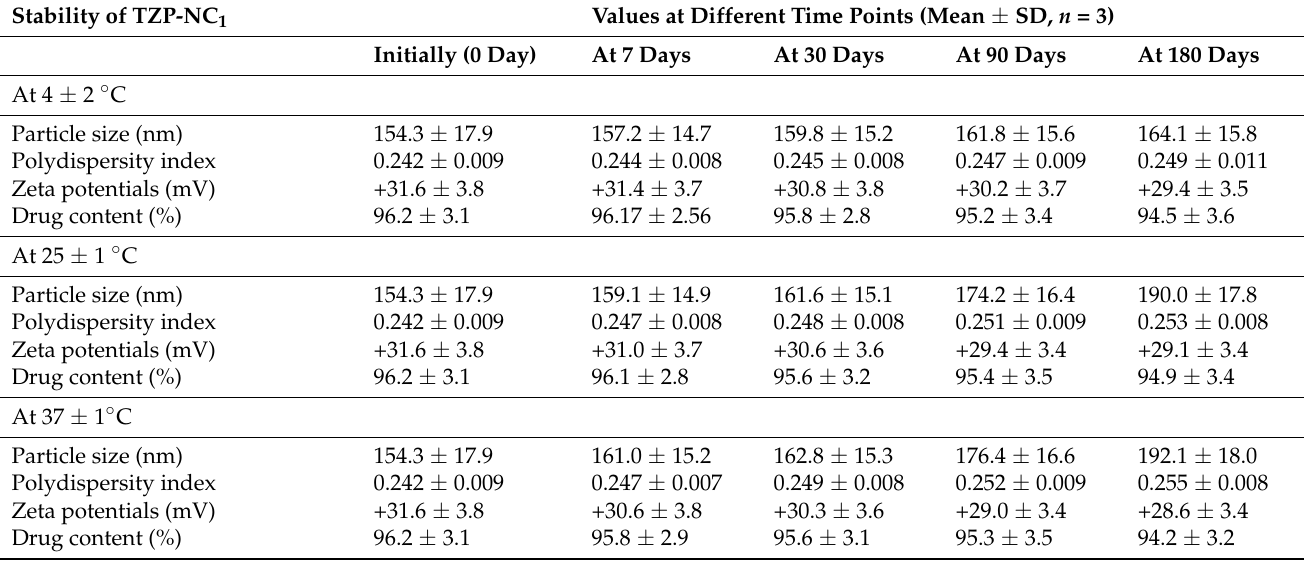
Table 6. Stability results of TZP-NC 1 . All data were presented as mean ± SD, n = 3. Stability of TZP-NC